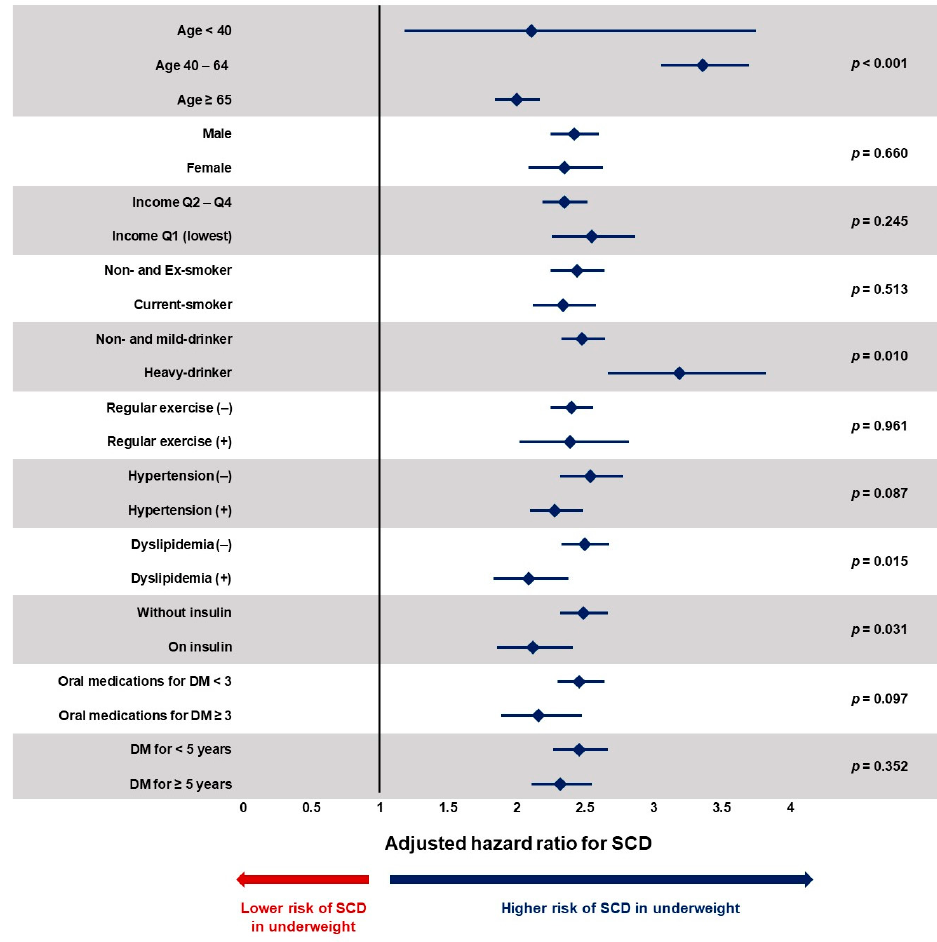
Figure 3. Subgroup analysis. DM: diabetes mellitus; SCD: sudden cardiac death. Despite significant interactions with age, alcohol consumption, dyslipidemia, and insulin use, being underweight was associated with a significantly increased risk of SCD in all subgroups. Underweight is defined as those with BMI less than 18.5 kg/m 2 . Values are expressed as adjusted hazard ratio with 95% confidence interval. Hazard ratios are adjusted for age, sex, income level, smoking history, alcohol consumption, regular physical activity, hypertension, dyslipidemia, fasting glucose, duration of DM, use of insulin, and number of oral antidiabetic